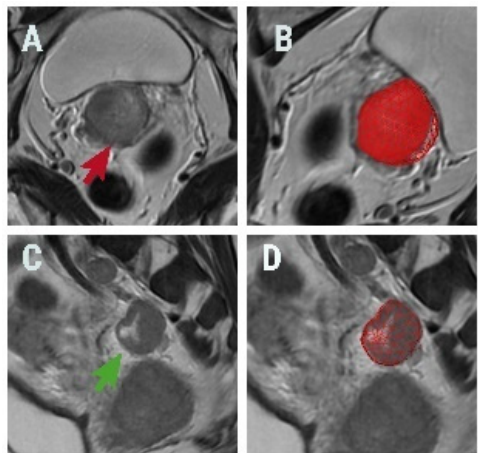
Figure 1. ( A ) Oblique axial T2-weighted image of a 55-year-old patient with squamous cervical carcinoma (red arrow) and ( B ) a three-dimensional (3D) region of interest (ROI) (red) covering the tumour. ( C ) Sagittal T2-weighted image of a 61-year-old patient with histologically proven metastatic lymph node (green arrow) and ( D ) the 3D ROI (red) covering the lesion. Over 300 parameters were extracted from the texture analysis of each ROI. These param- eters, originating from the texture analysis of each ROI, yielded more than 300